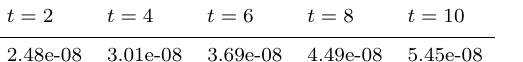
Table 1. L 2 − errors with N = M = 10, ν = 1 and τ = 0 . 001. t = 2 t = 4 t = 6 t = 8 t = 10